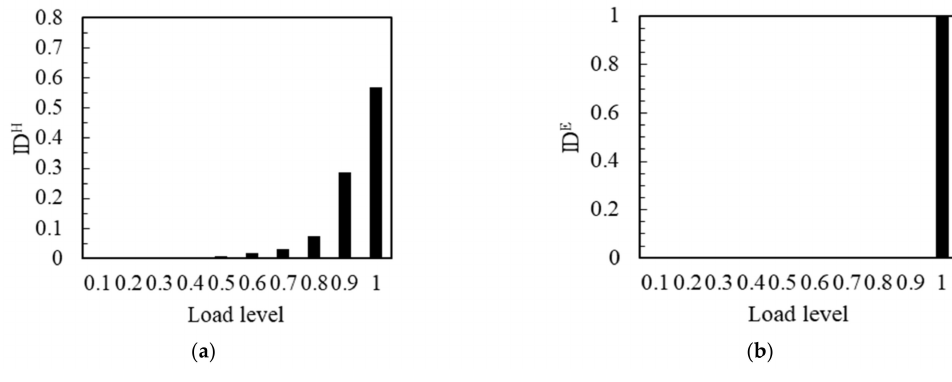
Figure 7. ID H and ID E of the No. 14 notched beam: ( a ) ID H ; ( b ) ID E